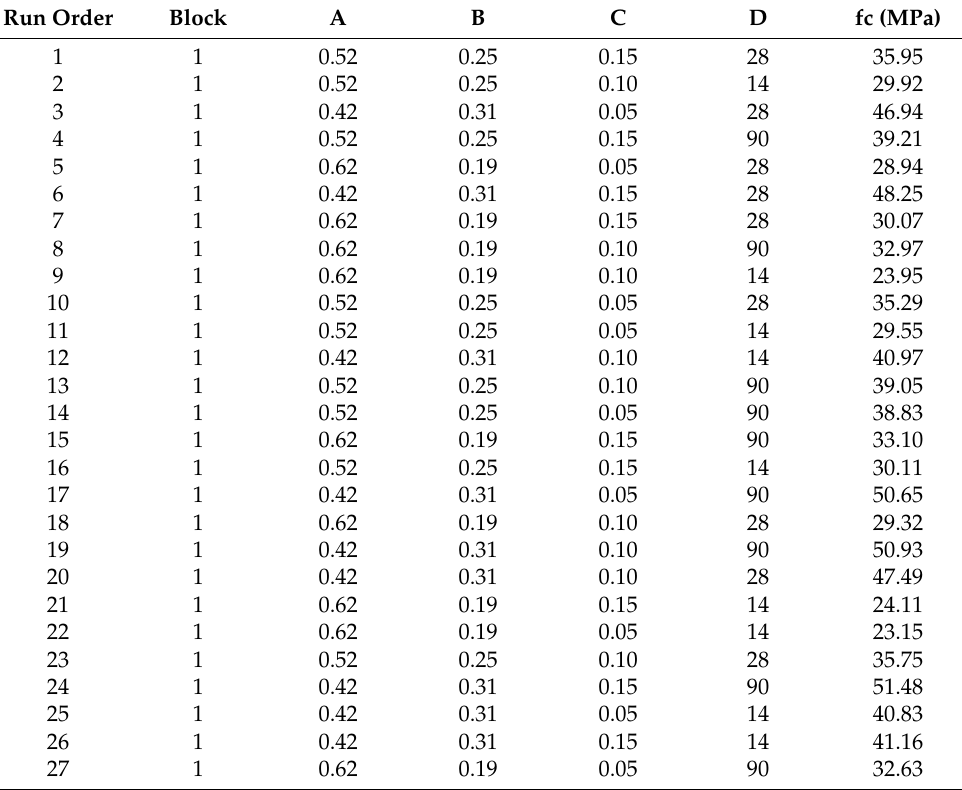
Table 6. Results of the response surface design using BBD.